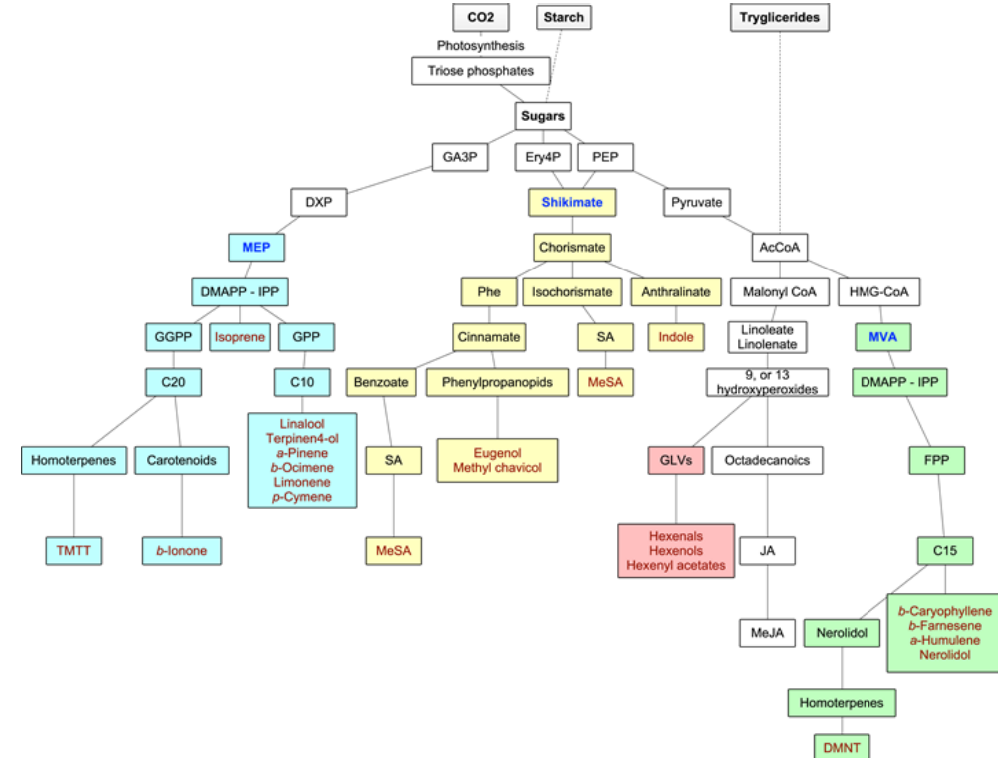
Figure 2. Main biosynthetic pathways for BVOCs. In green and yellow colors, the methylerythritol phosphate (MEP) and mevalonate (MVA) pathways to isoprenoids, respectively, in blue color, the lipoxygenase (LOX) pathway to GLVs, and in purple color, the shikimate pathway to aromatic compounds. Adapted from Maffei et al. (2011) [17].